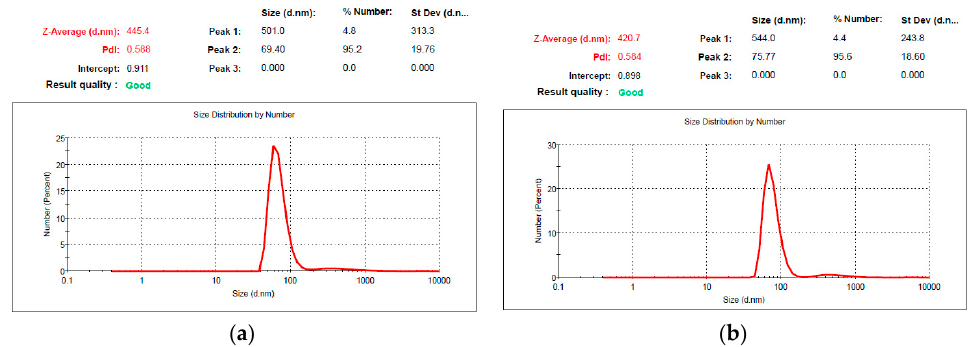
Figure 2. Size and size distribution for void microemulsion ( a ) and curcumin encapsulating micro- emulsion ( b ).